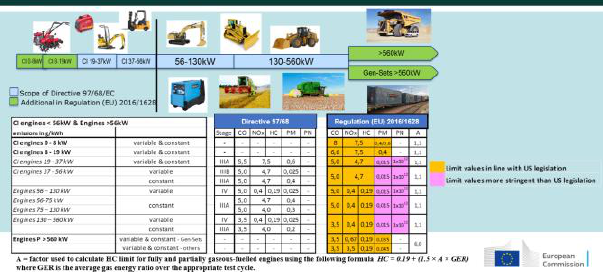
Fig. 6. Outline of the legislative structure for setting emissions control for land-based NRMM, with emissions limits [35] Prof. Kohei Nakashima (Meijo University, Japan)